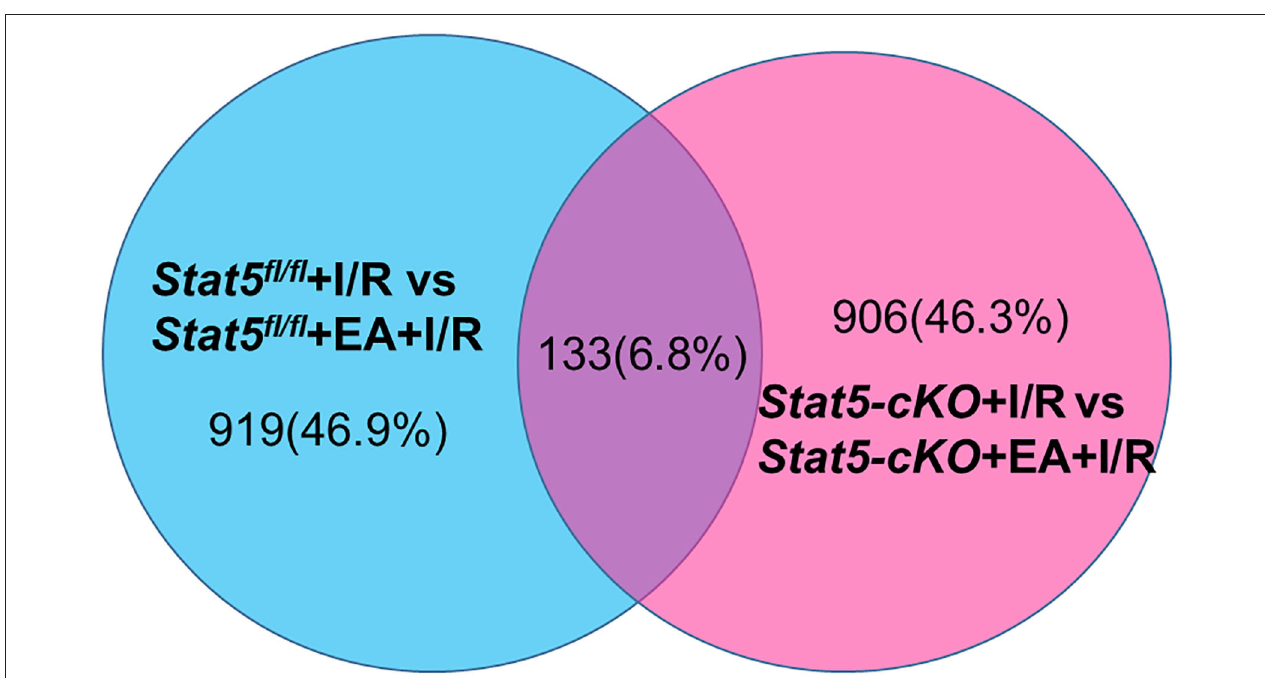
FIGURE 5 | Venn diagrams and clustering analysis of RNA-seq results. Venn diagrams were drawn based on the RNA-seq datasets. The blue circle indicates the numbers of up- and downregulated genes in the Stat5 fl / fl + EA + I/R group vs . the Stat5 fl / fl + I/R group the pink circle represents the numbers of up- or downregulated genes in the Stat5- cKO + EA + I/R group vs . the Stat5- cKO + I/R group. A total of 133 genes overlapped between these two